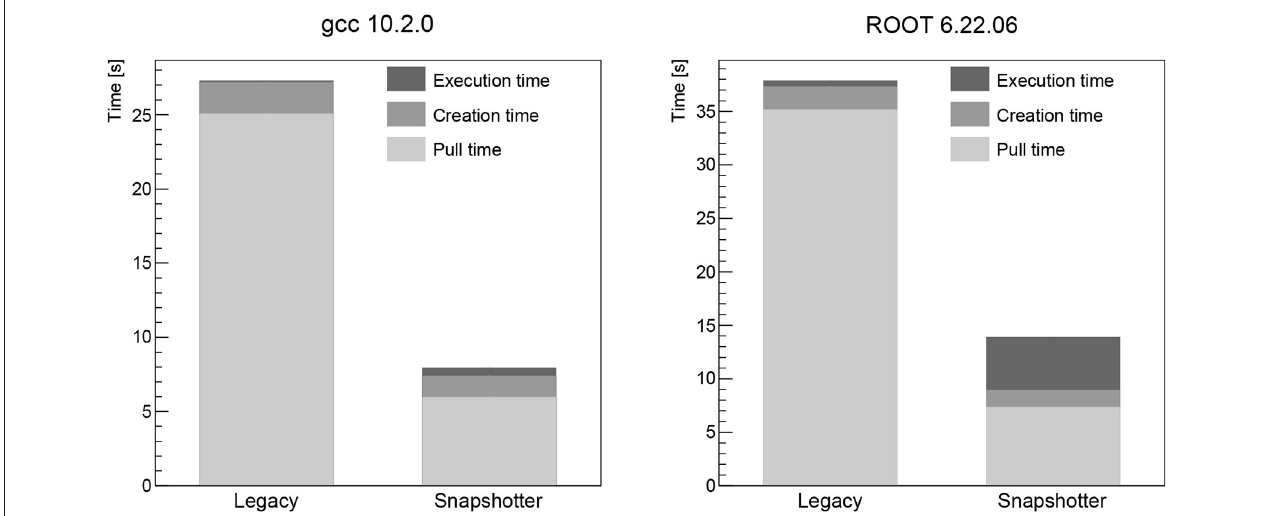
FIGURE 2 | Summary of the overall run time of the gcc (Left) and ROOT (Right) workloads analyzed split into the container image pull time, the time to start the job after the container is ready as well as the time for the actual workload comparing the legacy and the snapshotter approaches. For the ROOT workload, a large fraction of the image data is required and downloaded during the execution stage, significantly increasing the execution time.